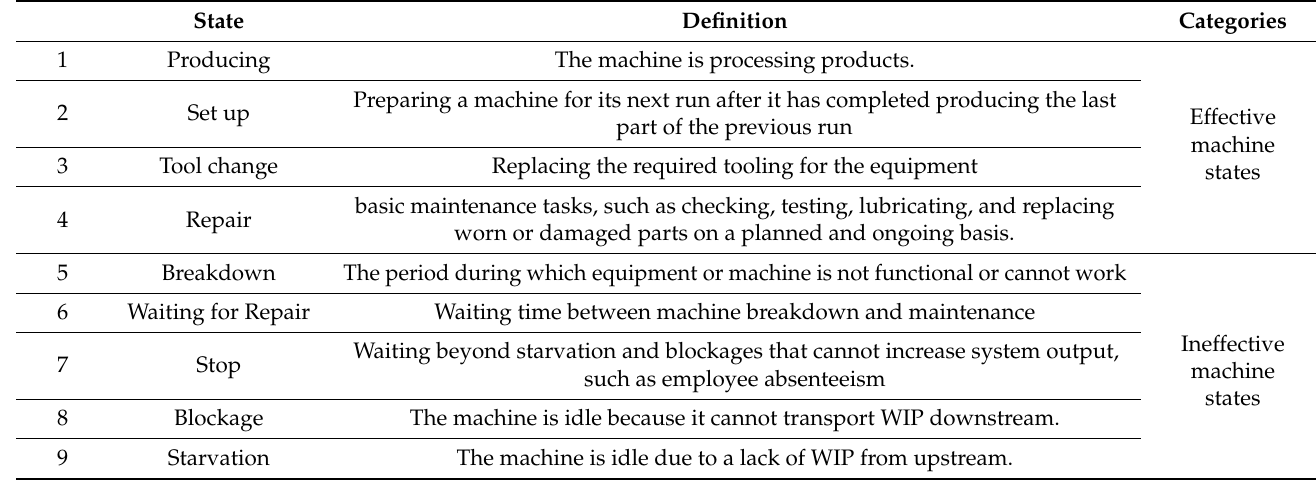
Table 3. Fine-grained states of manufacturing